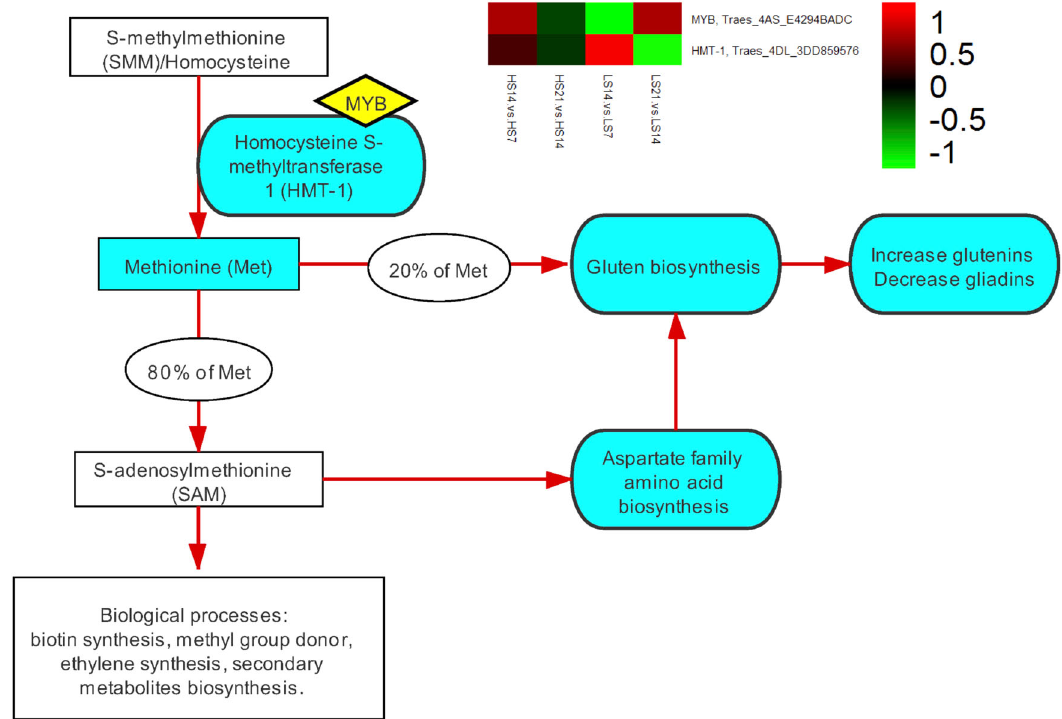
Fig. 4 Sulfur-mediated molecular mechanism for methionine biosynthesis. LS (S0) and HS (S30) mean 0 and 30 kg ha − 1 sulfur treatments, respectively; Met methionine, HMT-1 homocysteine S-methyltransferase 1, DPA days post-anthesis, HS7: S30 at 7 DPA, HS14: S30 at 14 DPA, HS21: S30 at 21 DPA, LS7: S0 at 7 DPA, LS14: S0 at 14 DPA, LS21: S0 at 21 DPA; the heatmap: each row represents a single gene and each column represents a library constructed between two grain developing stages at S0 or S30; the heatmap colour scale: red, green and black indicate upregulation, downregulation and no change, respectively. The gene annotated as MYB ( TraesCS4A02G124900 ) was directly interacting with the gene TraesCS4D02G242100 annotated as HMT-1 in the regulation of Met biosynthesis as a part of the aspartate-family amino acid biosynthesis network. At S30, the expression of the two genes is simultaneously upregulated as grain developing until 14 DPA, followed by a concurrently downregulated until 21 DPA; while at S0, the expression of MYB is downregulated but the expression of HMT-1 is upregulated from 7 to 14 DPA, followed by a reversed pattern from 14 to 21